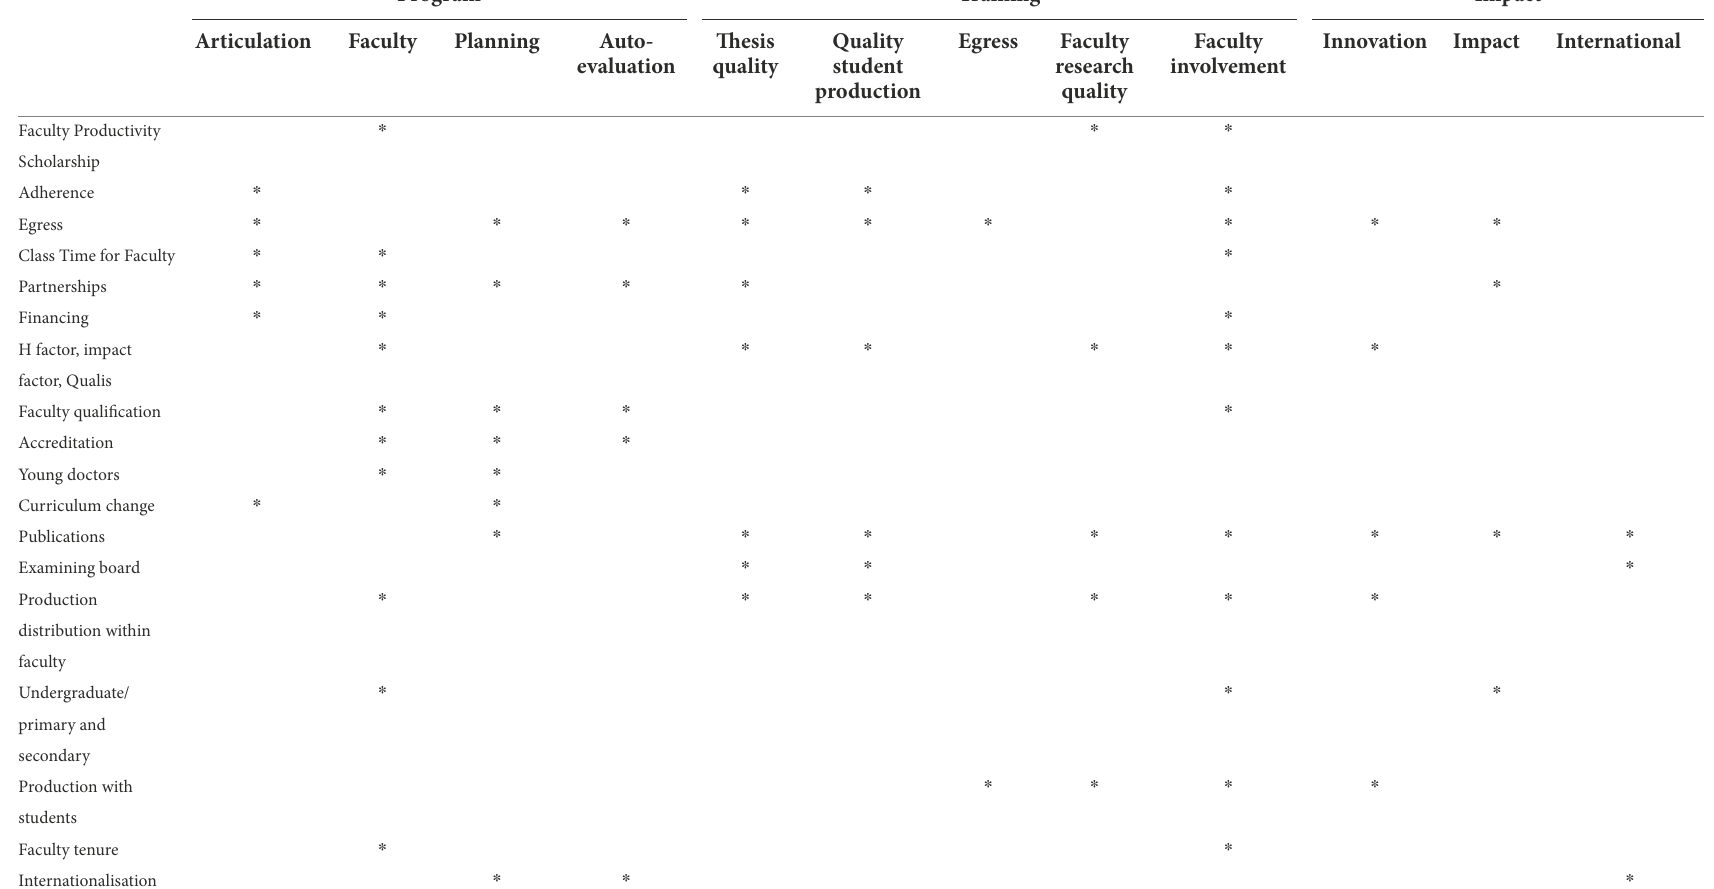
TABLE 5 Use of indicators in the different questions and evaluation